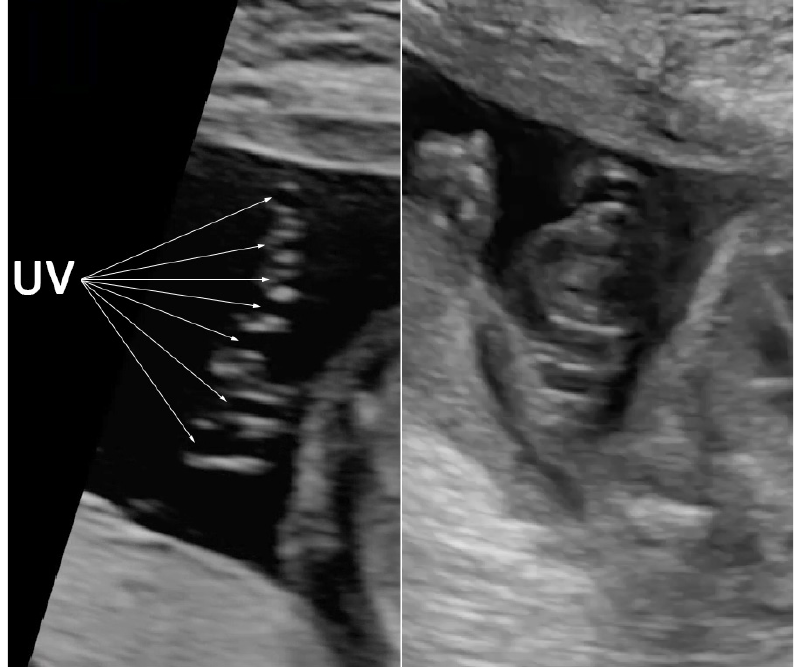
Figure 2. Prenatal ultrasound shows hypercoiling of the umbilical cord (7 loops in a 6 cm length) (UV: umbilical vein).